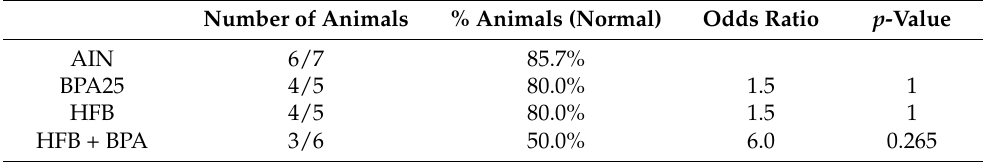
Table 4. Presence of spermatozoa in >20% of STs in testes of F3-generation SD rats (aging